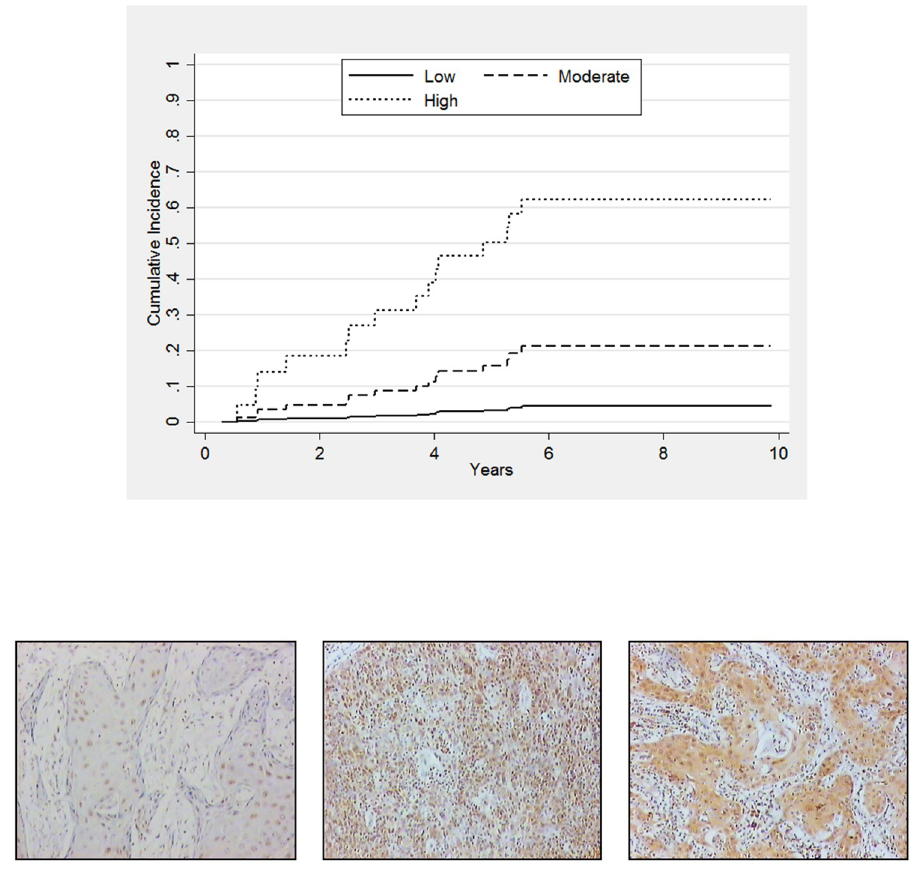
following primary treatment is significantly increased in the high-risk group compared to the moderate- and low-risk groups. High risk: LS & PTCH1 under-expression; Moderate-risk: Either LS or PTCH1 under-expression;